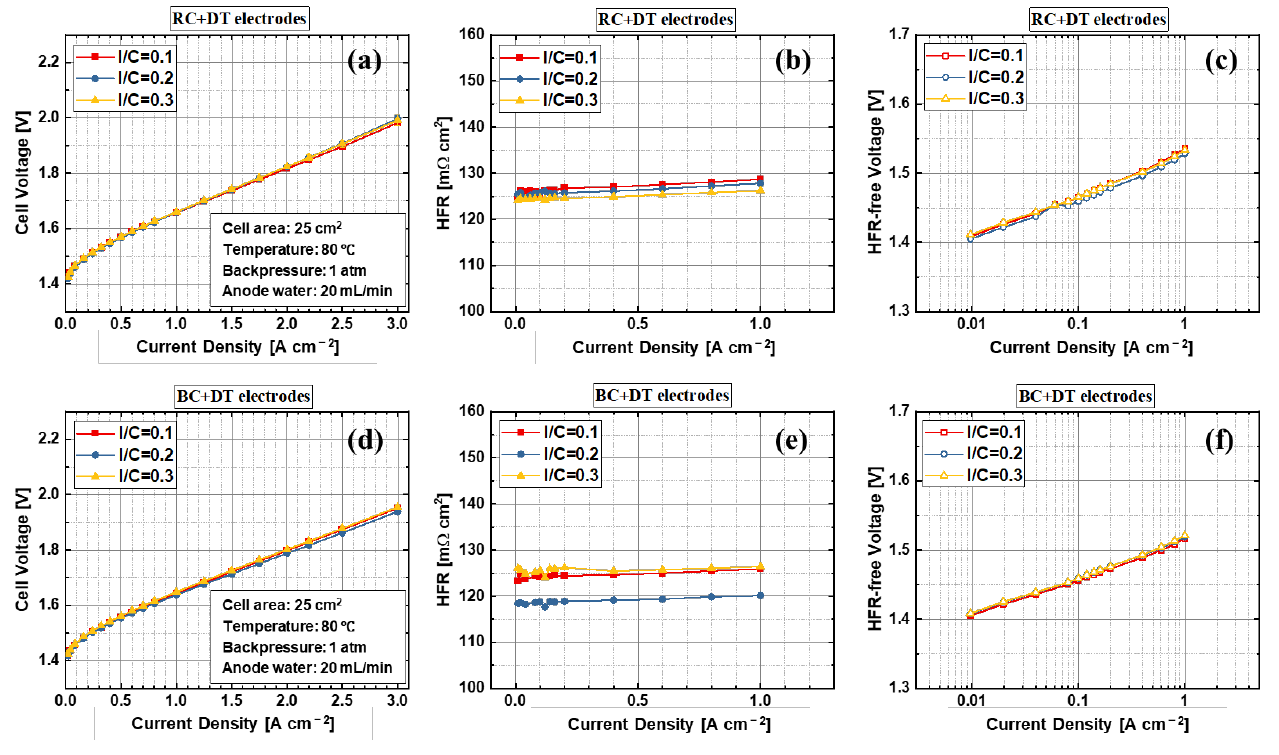
Figure 6. Effects of the ionomer to catalyst ratio in anode electrode ink ( a , d ) performance, ( b , e ) HFR, and ( c , f ) Tafel slopes with two fabrication methods: ( a – c ) rod coating and decal transfer, and ( d – f ) blade coating and decal transfer.